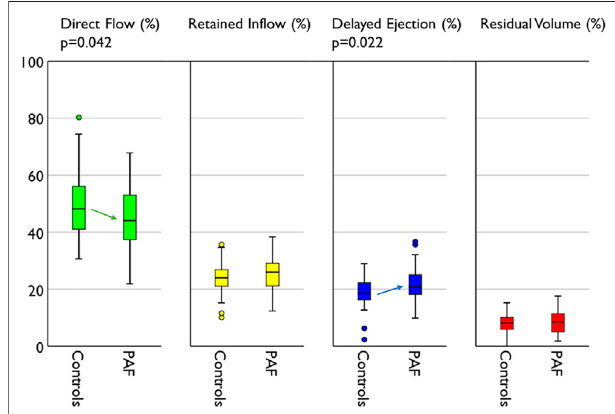
FIGURE 4 | Compare of fl ow distribution between groups. PAF group representsreduceddirect fl owandincreaseddelayedejectioncomparedwith